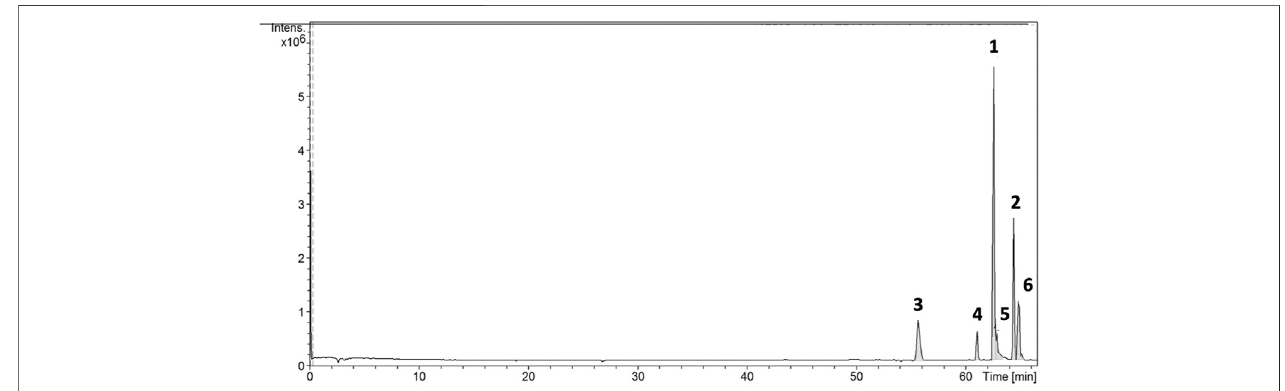
FIGURE 2 | Chromatogram obtained from LC-ESI-MS-MS analysis of the fl avone-rich fraction of Arrabidaea chica Verlot, also presenting 6 peaks of fl avones. Luteolin ( 1 ), apigenin ( 2 ), 6-hydroxy-luteolin ( 3 ), scutellarein ( 4 ), caraju fl avone ( 5 ), and chrysoeriol ( 6 ).